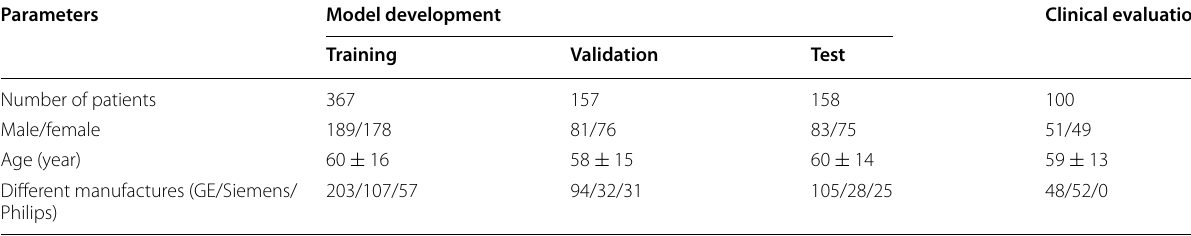
Table 1 Basic characteristics of the enrolled subjects for model development and clinical evaluation set.